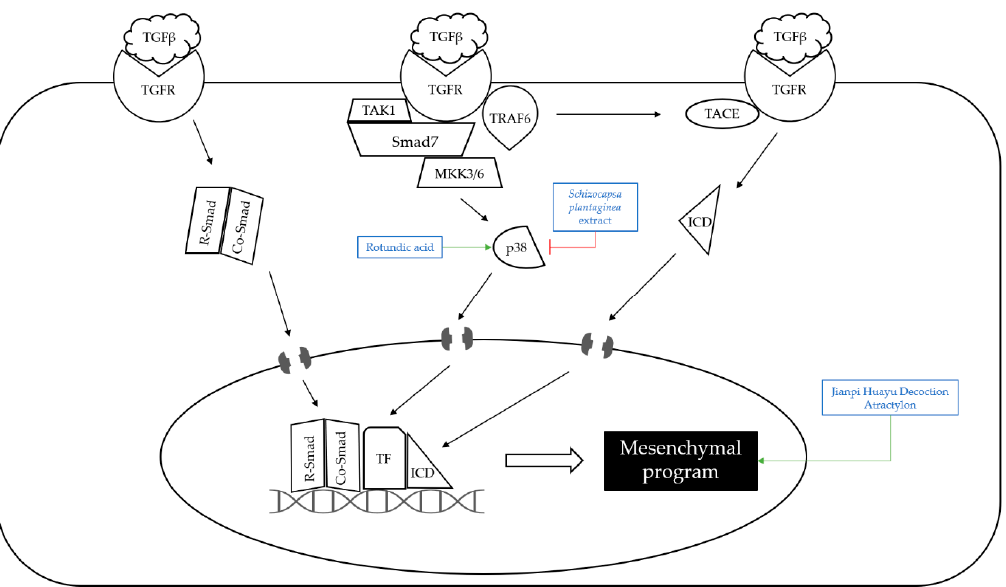
Figure 2. Schematic diagram of metastasis. Metastasis starts with TGF receptor stimulation, which induces the complex of R-Smad and Co-Smad, as well as p38 and ICD to move into the nucleus. These factors control gene transcription to upregulate the mesenchymal program. P38 was upregulated by rotundic acid and downregulated by Schizocapsa plantaginea extract. Jianpi Huayu Decoction and atractylon upregulated the mesenchymal program. The mechanisms of natural products affecting metastasis were indicated. The upregulations of the molecules were marked with a green arrow and the downregulations with a red arrow.